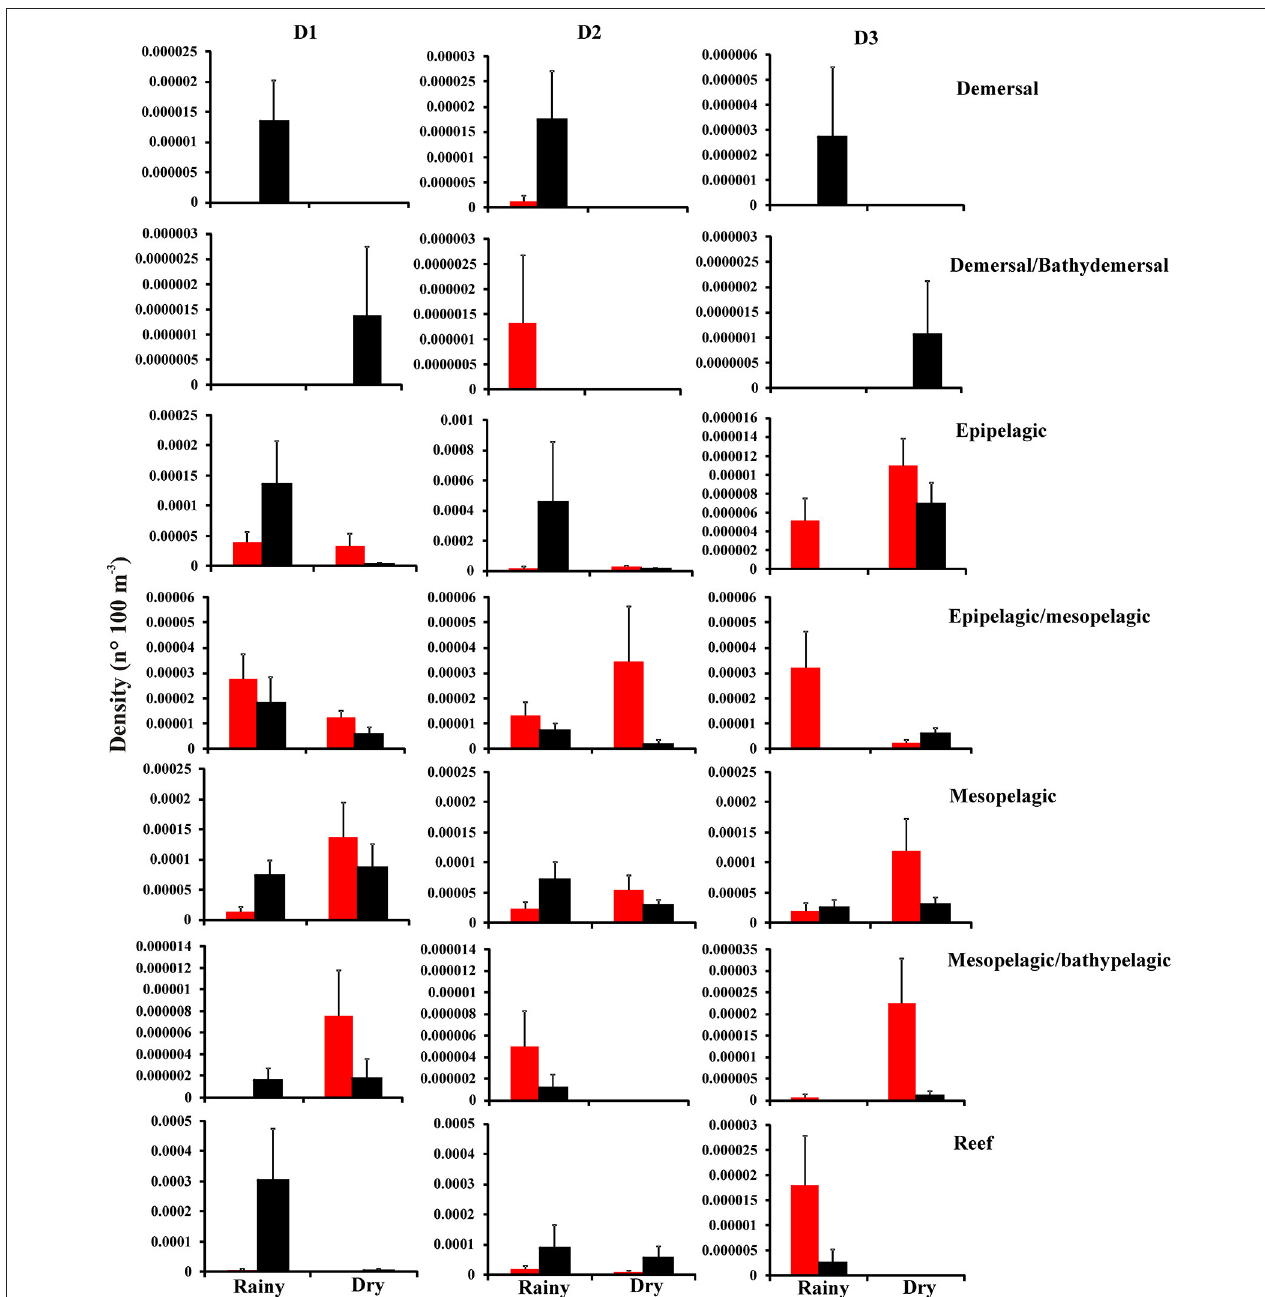
FIGURE 6 | Total mean ( + S.E.) density of larval assemblages according to the adult habitat in different periods [( ) day and ( (cid:4) ) night] at D1 ( < 100 m), D2 ( > 100–500 m), and D3 ( > 500–1500 m) for each season (rainy and dry).